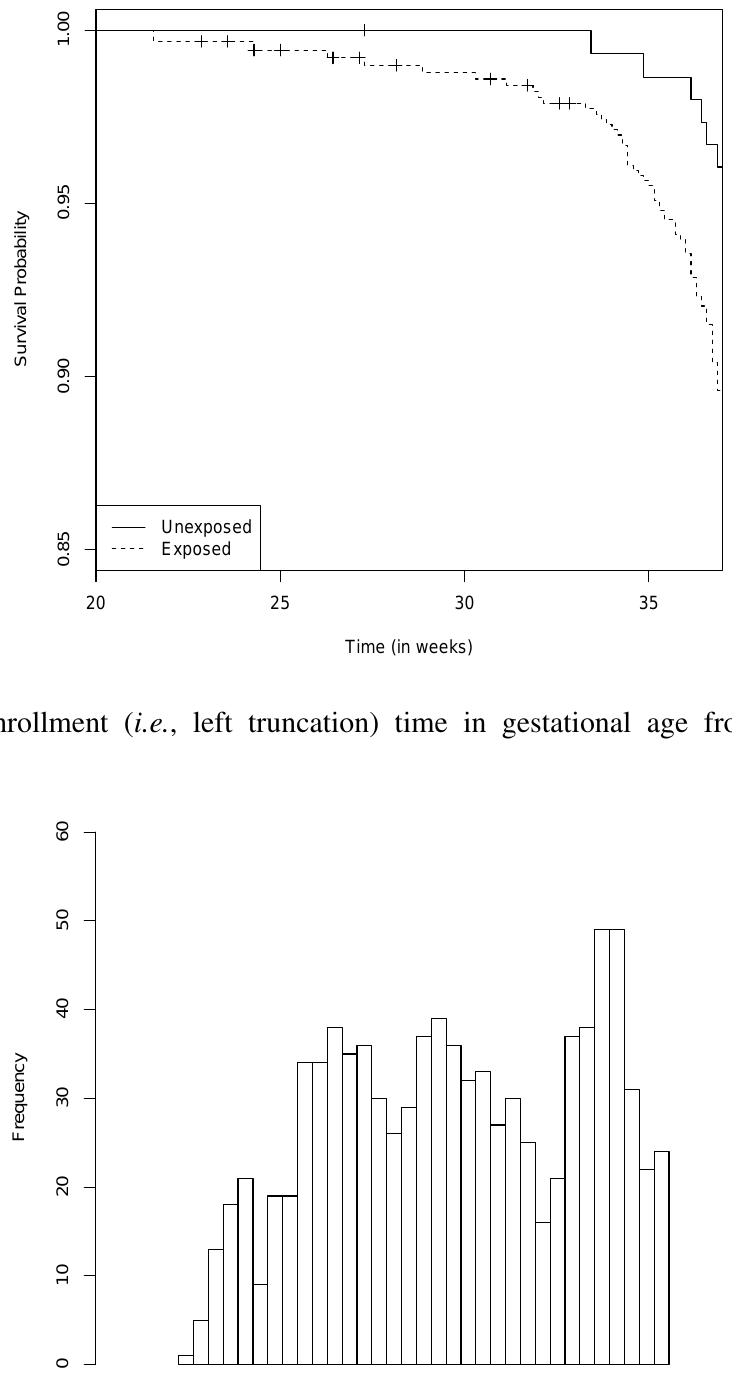
Figure 1. Left truncated Kaplan-Meier curves of one minus preterm delivery rates from the pH1N1 vaccine data.